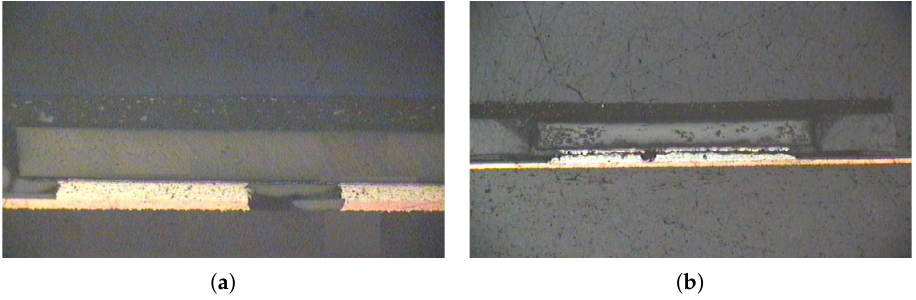
Figure 8. ( a ) A metallographic section of an unbroken SJL with no cracks. ( b ) A metallographic section of a broken SJL with evident transverse